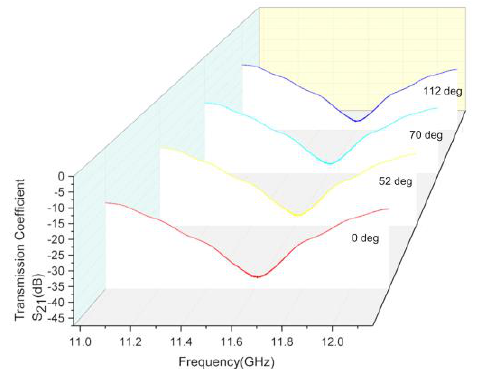
Figure 12. Measurement results when sensor bent to different curvatures.